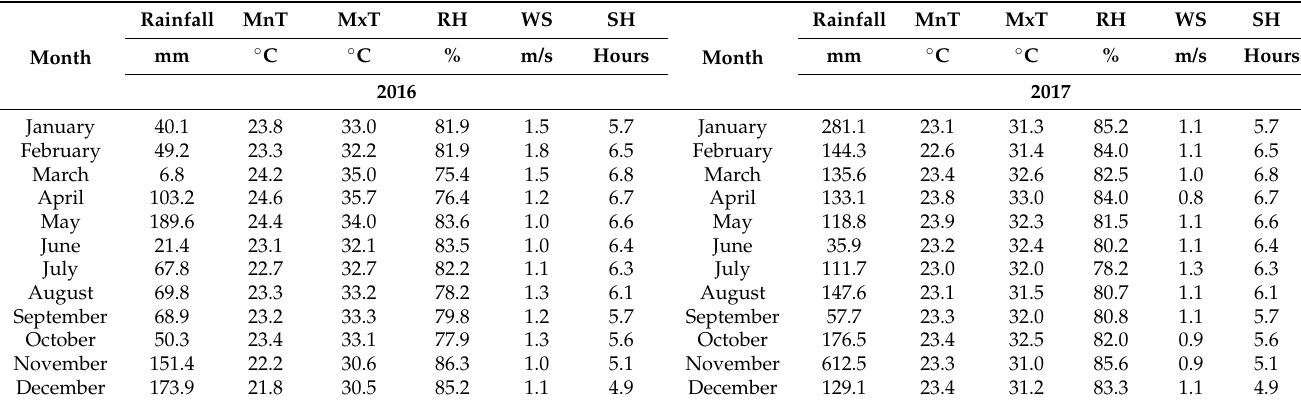
Figure 2. Google Earth map illustration showing the locations of detailed meteorological data collection sites. Sources used to estimate field data. Table 1. Summary of monthly meteorological data used in the FAO Cropwat model according to assessment